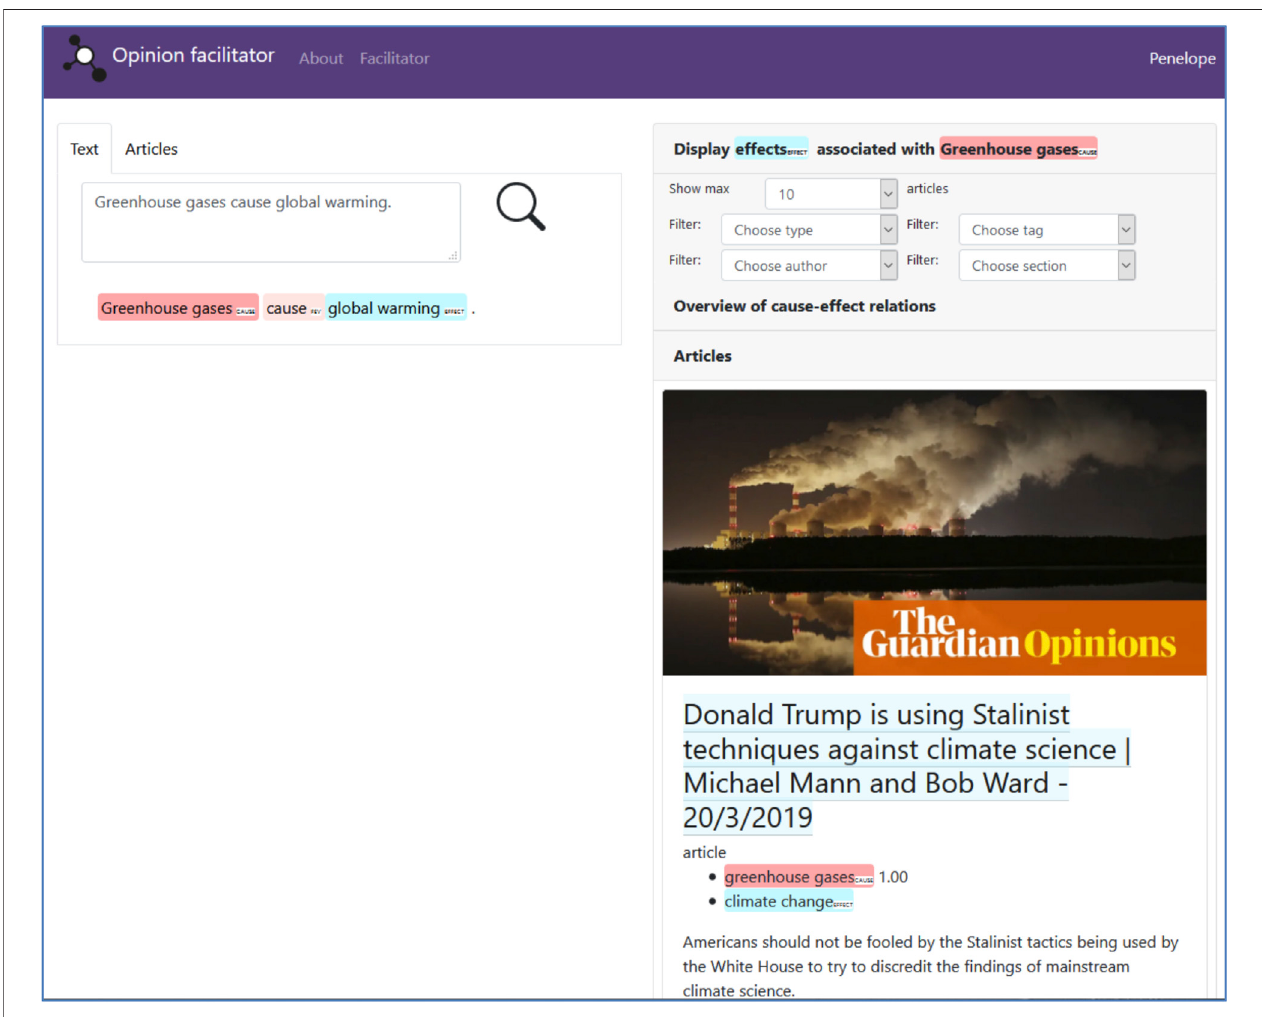
FIGURE 2 | Screenshot of the Penelope opinion facilitator ’ s user interface. In the left-hand section of the screen, users can enter a causal statement or browse articles.Inbothcases, “ cause ” and “ effect ” frameelementsareautomaticallyhighlightedinthetext,and serveasabasisforfurthercomparison withotherarticles.Inthis case, the reader has clicked on the “ cause ” frame element “ greenhouse gases ” in the statement “ Greenhouse gases cause global warming. ” The system then displays articles that mention articles containing alternative “ effect ” frame elements associated with the “ cause ” frame element “ greenhouse gases. ” The suggested articles arerankedonthebasisofthesimilaritybetweentheprovided “ cause ” frameelementandtheretrieved “ cause ” frameelementsinthearticles.Userscanreadthefulltexts of the articles and have the option of fi ltering by a. o. author names in order to explore alternative perspectives on the issue at hand.